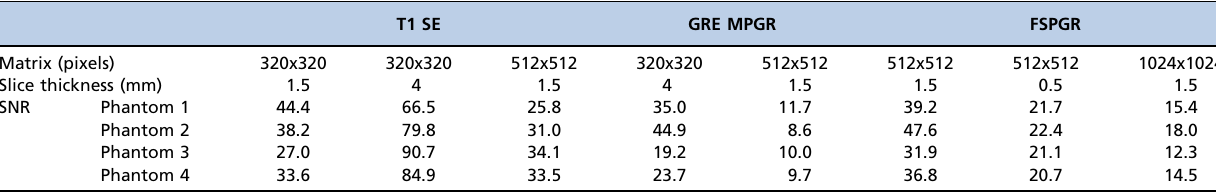
Table 2 - Signal-to-noise ratios for the magnetic resonance imaging sequences employed in this study. T1 SE GRE MPGR FSPGR Matrix (pixels) 320x320 320x320 512x512 38.2 79.8